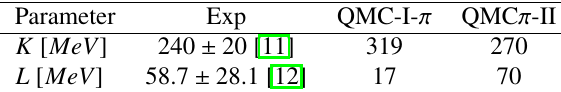
Table 2. The values of incompressibility K and slope of symmetry energy L for previous and latest QMC models compared to their generally accepted values coming from various